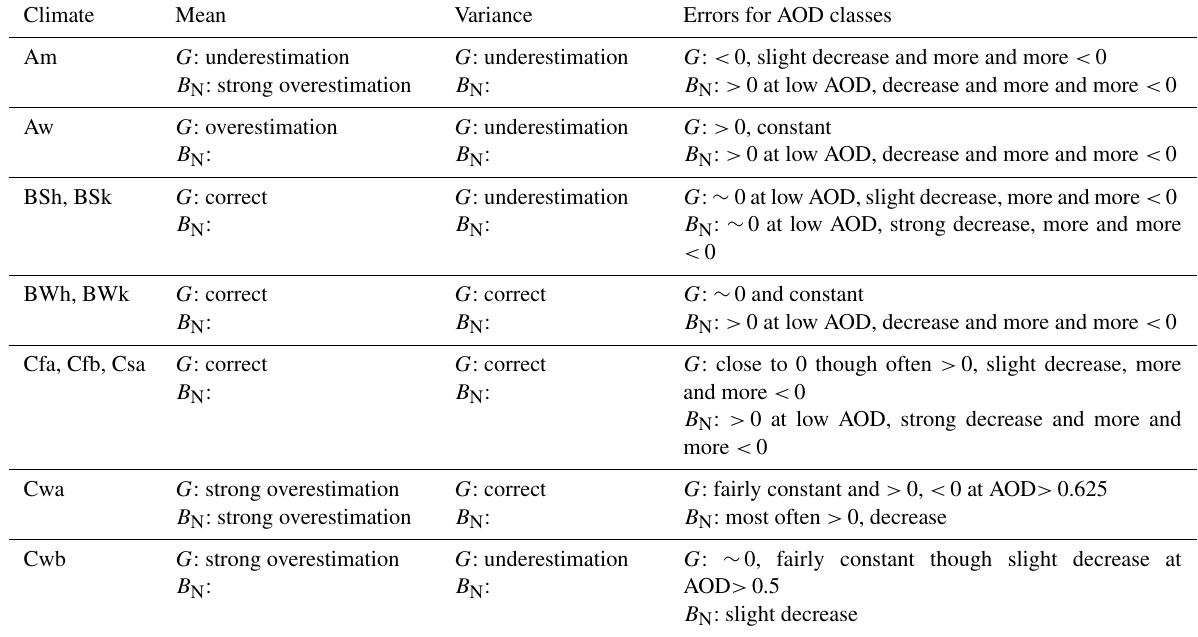
Table 12. Summary of errors in means and variances and for AOD classes for each climate. Climate Mean Variance Errors for AOD